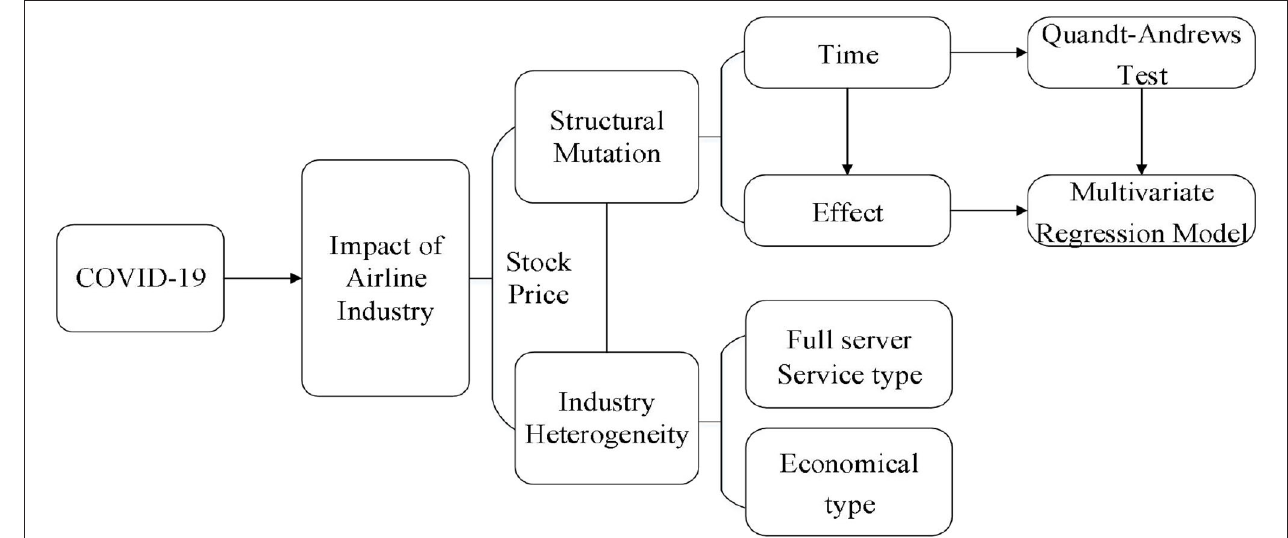
FIGURE 1 | Research